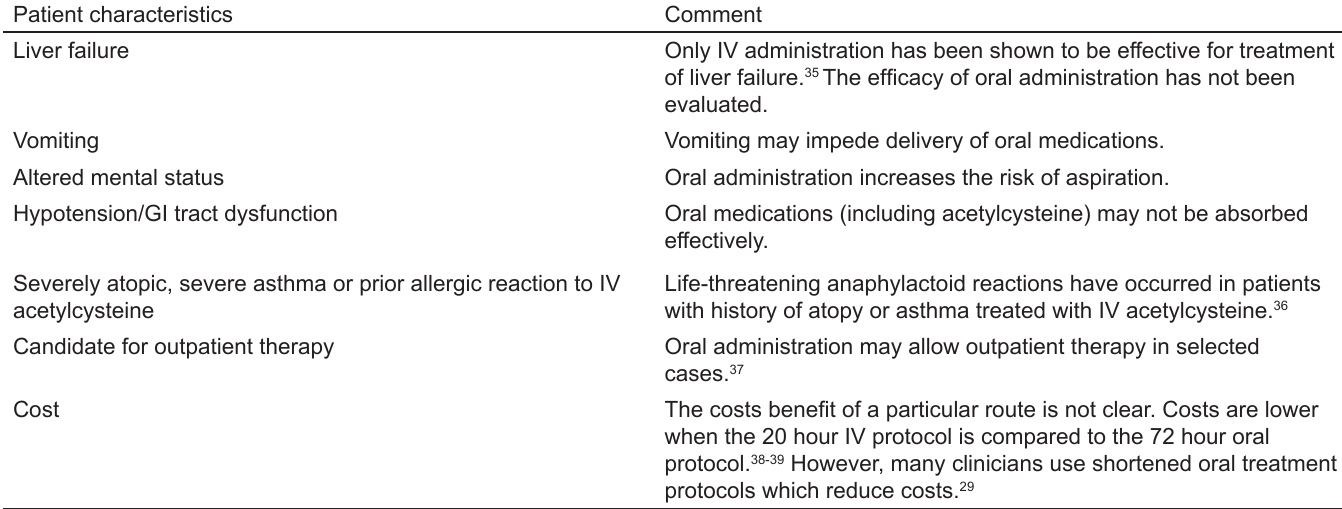
Table 2 . Factors for clinicians to consider when selecting a route of administration for acetylcysteine during treatment of acetaminophen